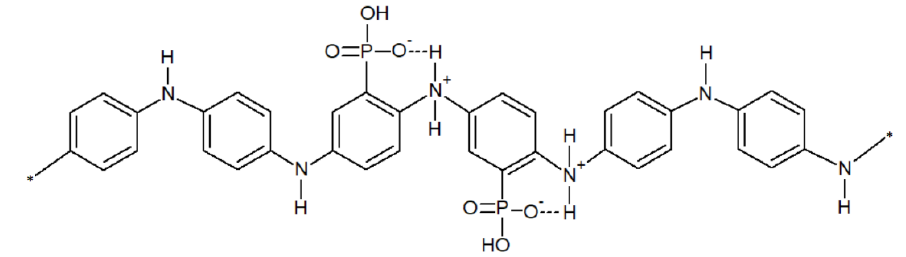
Scheme 2. Structure formed in PANI2APPA (50/50) by electrostatic effects.